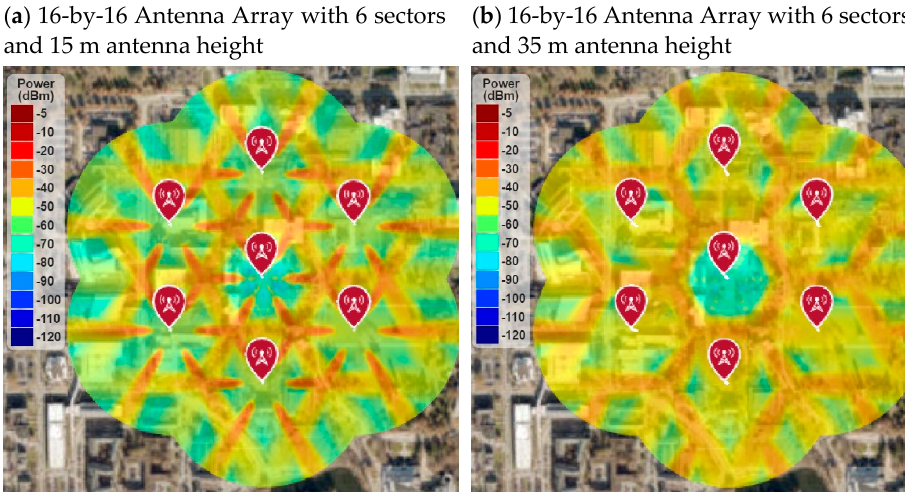
Figure 25. RF coverage and signal strength versus antenna height.